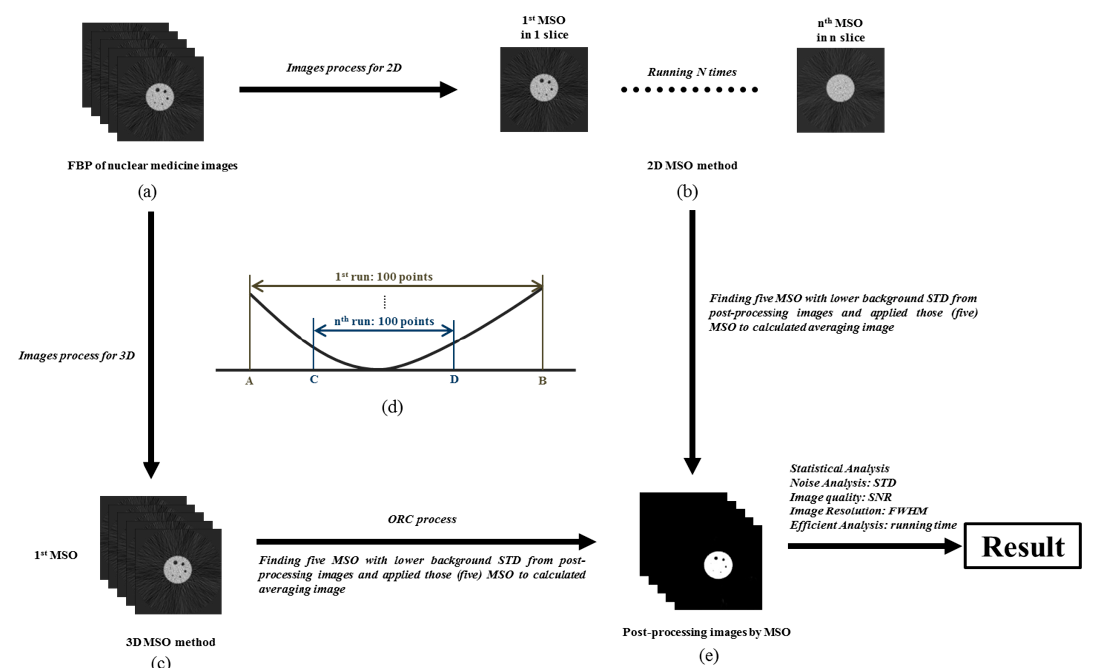
Figure 3. Study flow chart. The two-dimensional axial imaging method was used to run. 2D-MSO was used to process the FBP Deluxe Jaszczak phantom images with ORC. The two-dimensional axial nuclear medicine images ( a ). The images that were processed by 2D-MSO ( b ). The images that were processed by 3D-MSO ( c ). The operator data were defined and optimized by the principle of ORC ( d ). The post-processing images were quantified after three-dimensional MSO with ORC ( e ).